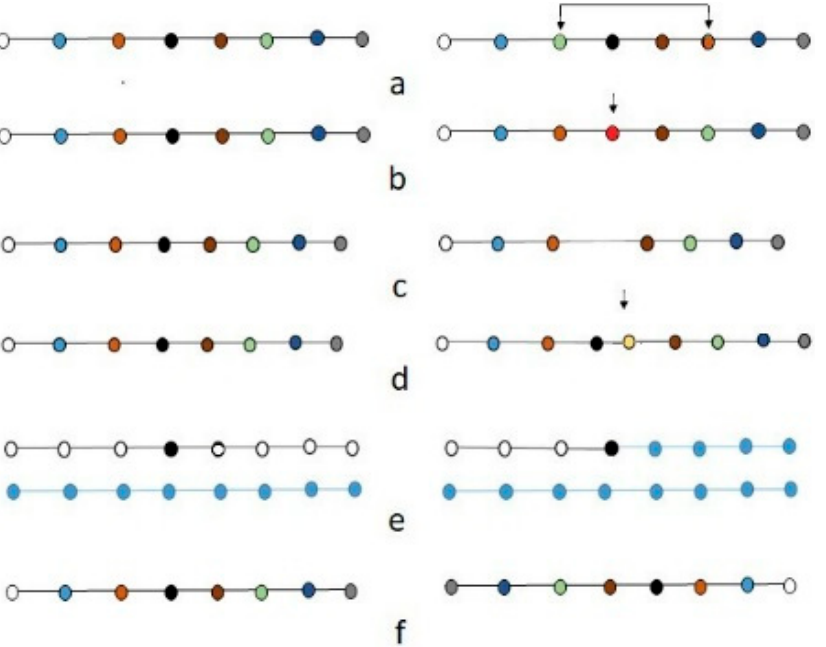
Figure 1. Neighbourhood moves: ( a ) node swap; ( b ) node replacement; ( c ) node removal; ( d ) node addition; ( e ) partial insertion; ( f ) route reverse.